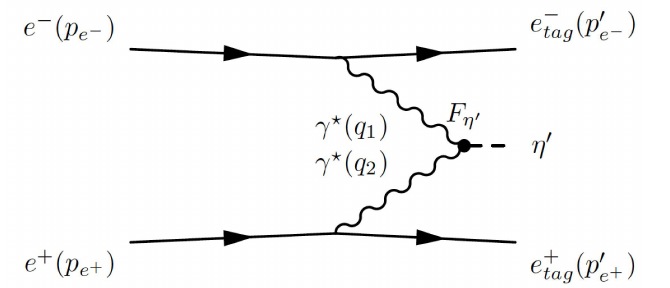
Figure 1. Feynman diagram for the two-photon process e + e − → e + e − η (cid:48) .